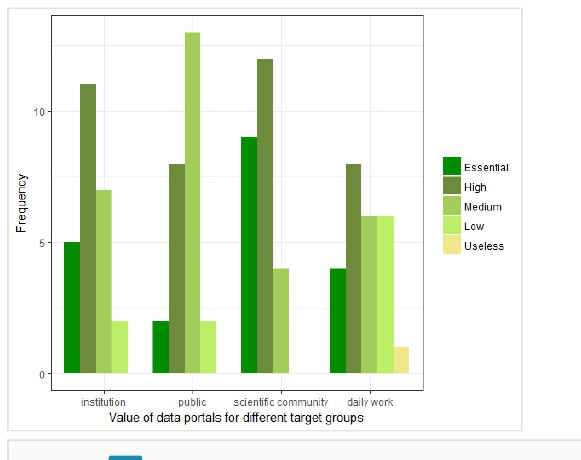
Figure 2. Estimated value of cross-institutional search possibilities through data portals on geoscienti fi c object (meta)data for di ff erent target groups. Shown is the frequency of answers for di ff erent scopes and their respective importance (see legend).